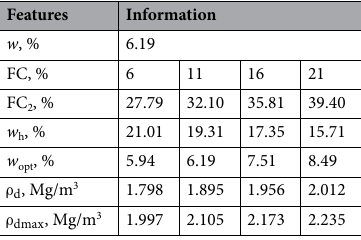
Table 1. Summary of